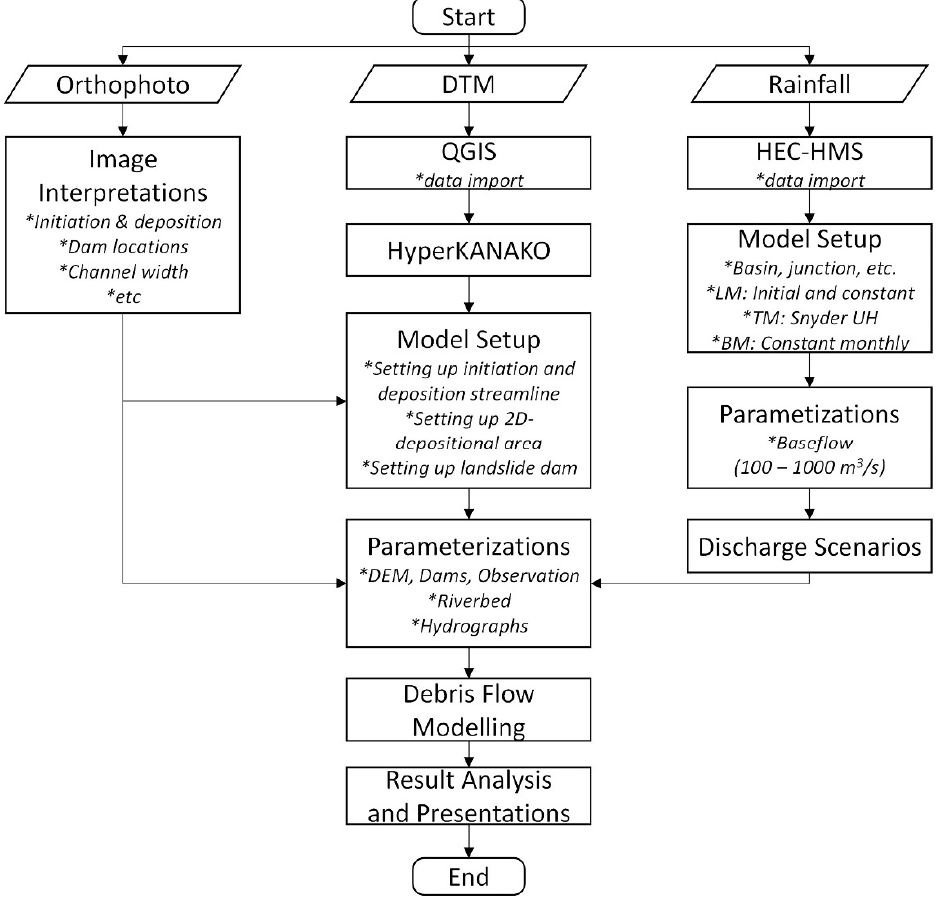
Figure 6. The overall flowchart of the study.